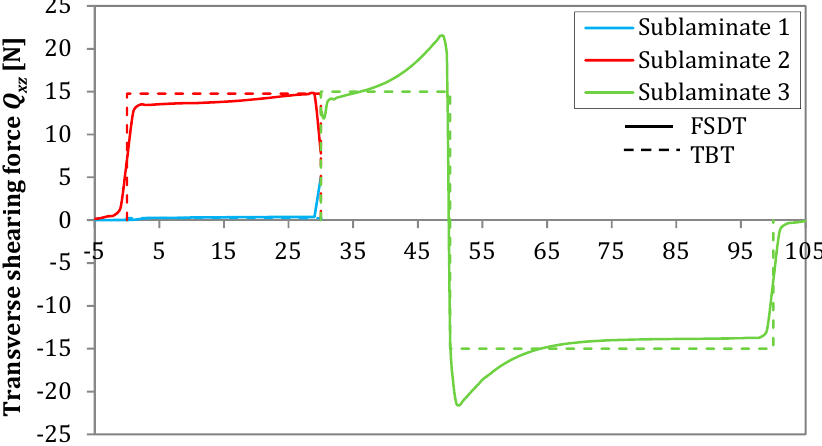
Figure 18. Transversal shear force Q xz distribution by analytical Timoshenko beam theory (TBT) and numerical first-order shear deformation theory (FSDT) model.